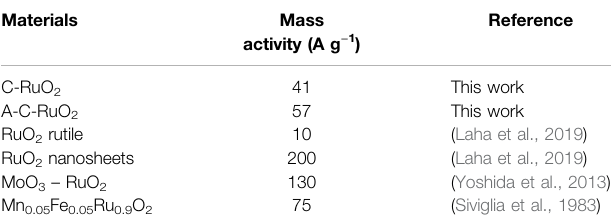
TABLE 2 | Comparison of mass activities measured on C-RuO 2 and A-C-RuO 2 with that of ruthenium-based catalysts from the literature.